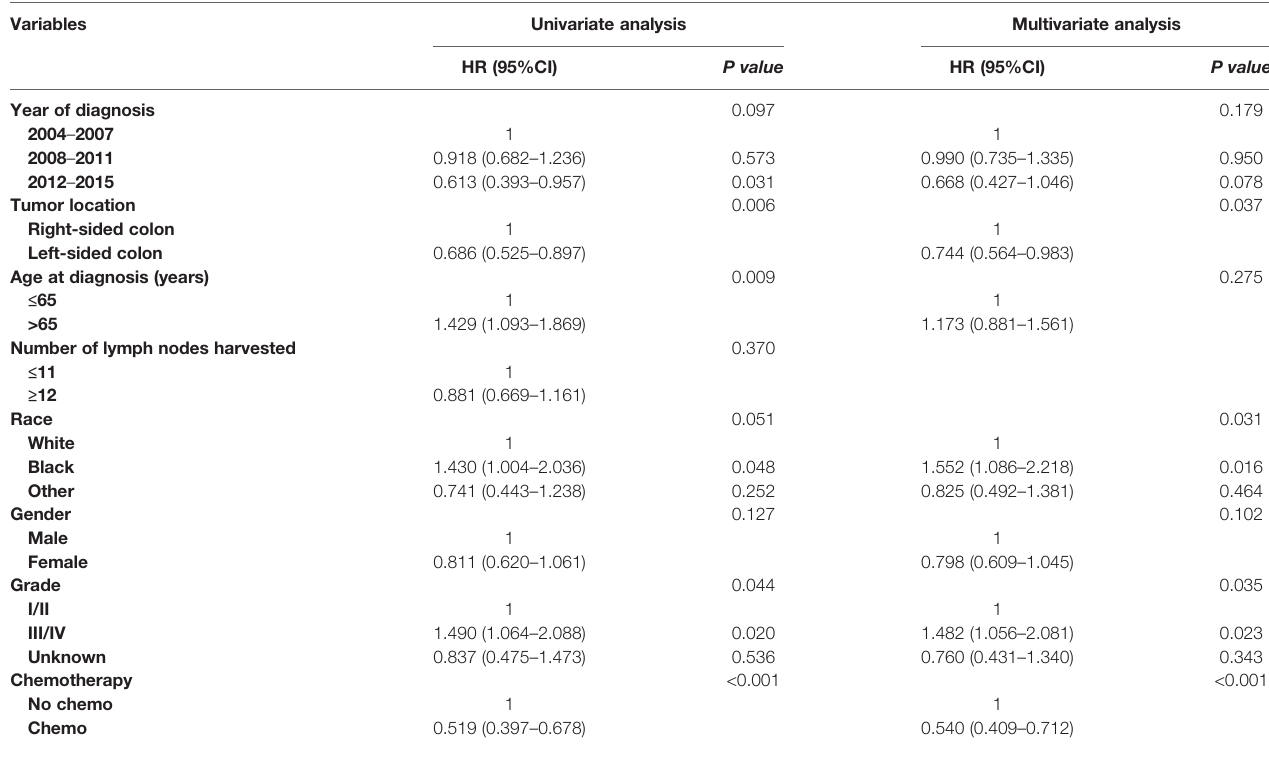
TABLE 2 | Cox regression analysis of prognostic factors for cancer-speci fi c survival in T1N+ colon cancer.